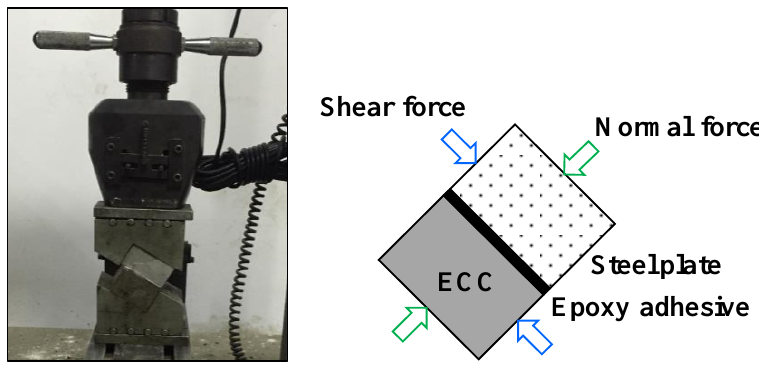
Figure 6. Inclined shear test.